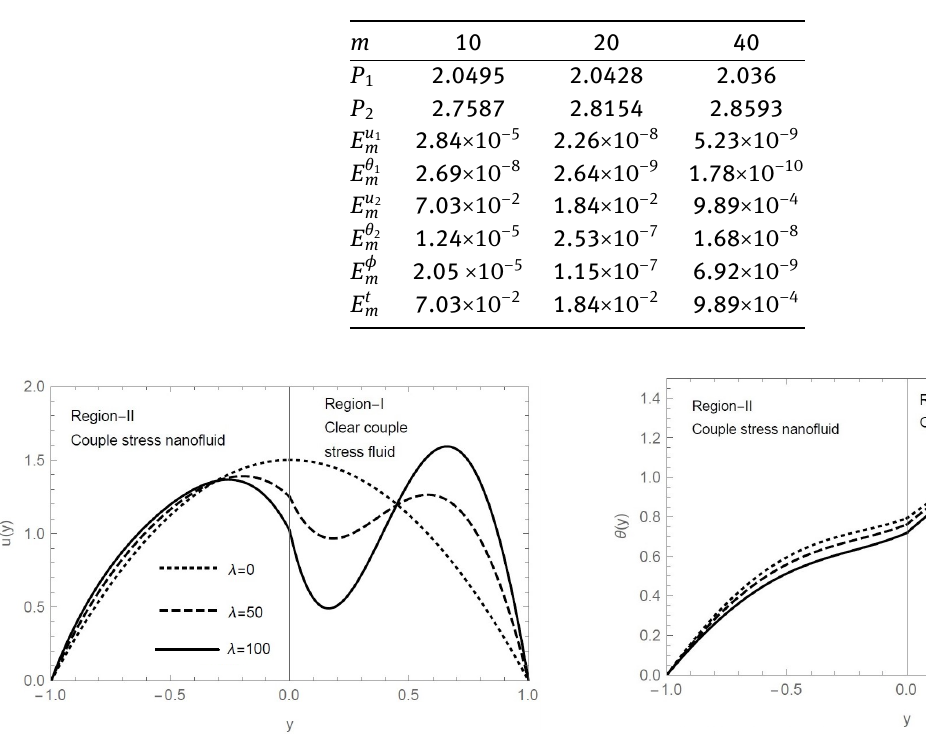
Figure 4: The influence of Brownian motion parameter N b on heat transfer keeping λ 1 = 50, Pr i = 5, h = 1, ξ i = δ i = 0.1, Γ i = 1, N t = 0.01 and µ = K = 0.5